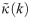
Traveling waves build periodic connectivity patterns into the synaptic strengths through STDP.
A. Example of a STDP rule (top panel, τ
+ = 20 ms, τ
− = 40 ms, A
+ = 1.0, A
− = 0.51) that is mapped into a location-dependent plasticity rule (bottom panel) by a wave traveling at 3 mm/s (burst duration is 0.1 s). B. Re[κ~(k)] for the STDP rule in A. The dominant spatial frequency, k*, lies where κ~(k) has a global maximum. Inset: κ~(k) for a symmetric STDP rule (τ
+ = 20 ms, v = 3 mm/s). C. Evolution of the synaptic strengths, initialized with strength 0.5, from 500 input neurons to a single output neuron, under the influence of an asymmetric (left column) and symmetric (right column) STDP rule. Waves sculpt a periodic connectivity pattern into the synaptic strengths with a spatial frequency equal to k* (see B and Eq 5). Larger values for τ
+ (controls STDP rule width) or v (wave speed) produce lower spatial frequencies in the periodic pattern. Values for τ
+ and v are given between the columns. D–E. Log-log plots for the spatial frequency of the steady state connectivity pattern as a function of τ
+ and v, for both the symmetric (left panels) and asymmetric (right panels) STDP rules. Grey curves: predicted k*; blue: mean spatial frequency ± SEM of the final connectivity pattern in the spiking simulation; purple: mean spatial frequency ± SEM of w(x) in the numerical solution to Eq 6. D. Dependence of the dominant spatial frequency on τ
+, keeping v = 3 mm/s fixed. E. Dependence of the dominant spatial frequency on v, keeping τ
+ = 20 ms fixed. F–G. Same as D and E, but for an integrate and fire output neuron model.